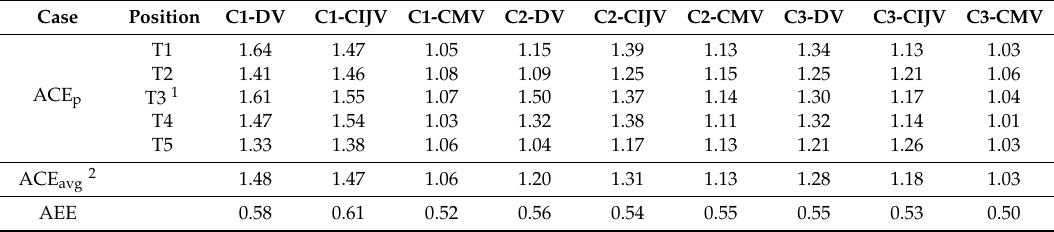
Table 4. Air change effectiveness (ACE), local and average, and air exchange effectiveness (AEE) for all cases.